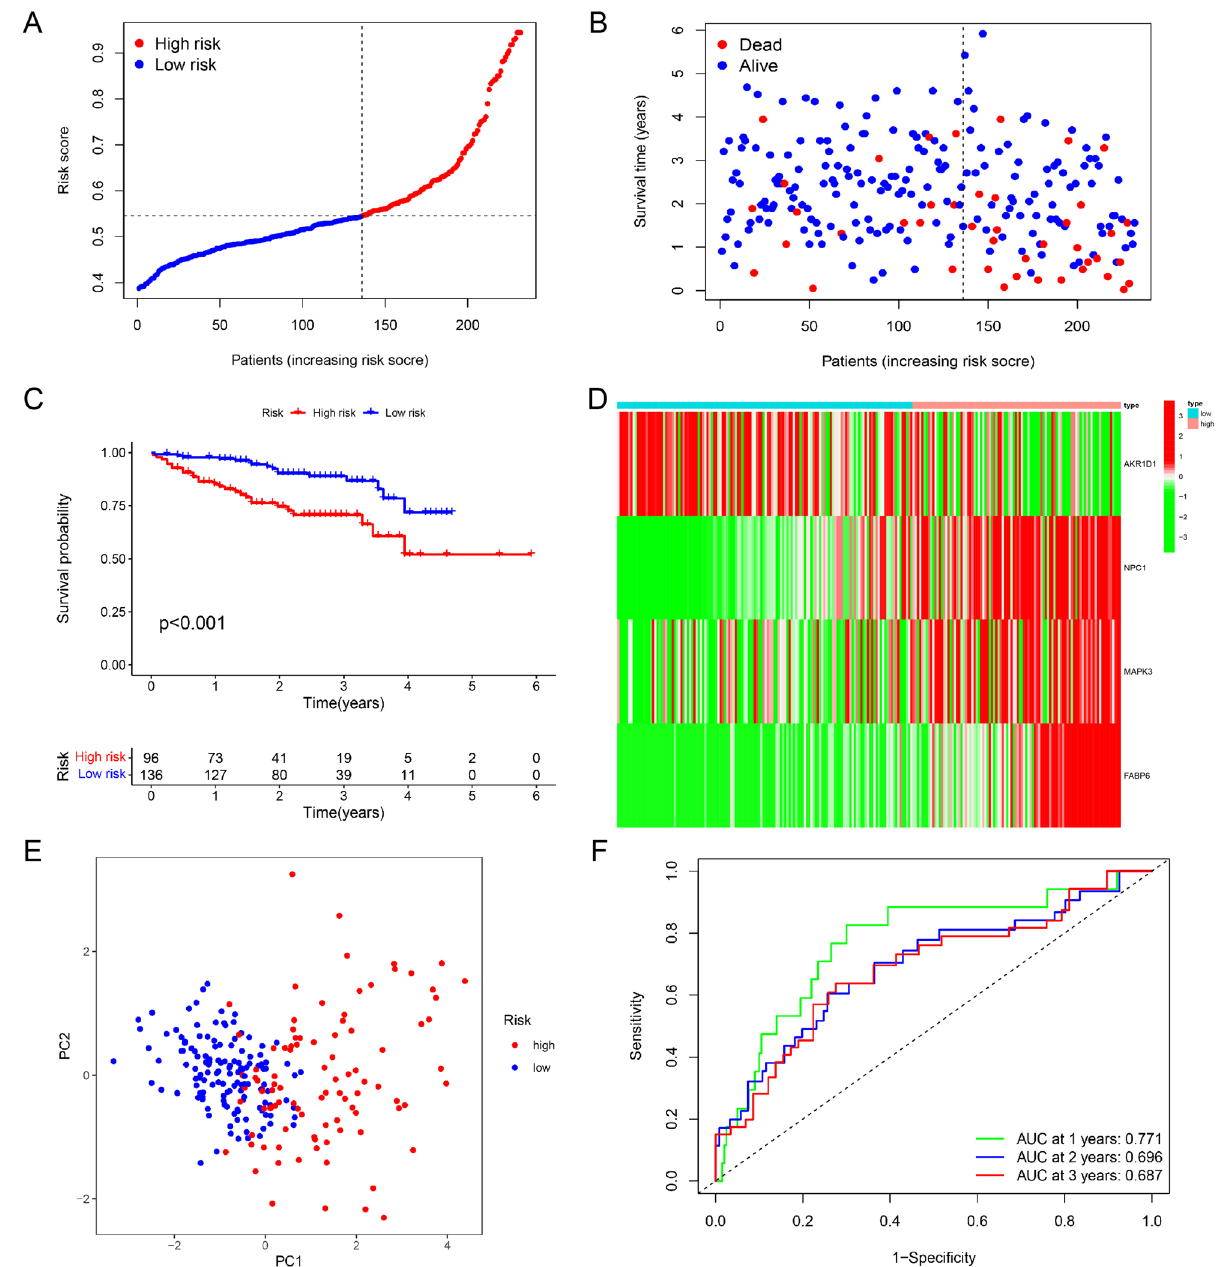
Figure 3. Verification of the bile acid-related risk signature in ICGC cohort. ( A ) Risk grouping based on TCGA median risk value. ( B ) Correlation between risk value and survival status. ( C – E ) KM curve, expression of modeling genes and PCA based on risk grouping. ( F ) ROC curves in ICGC